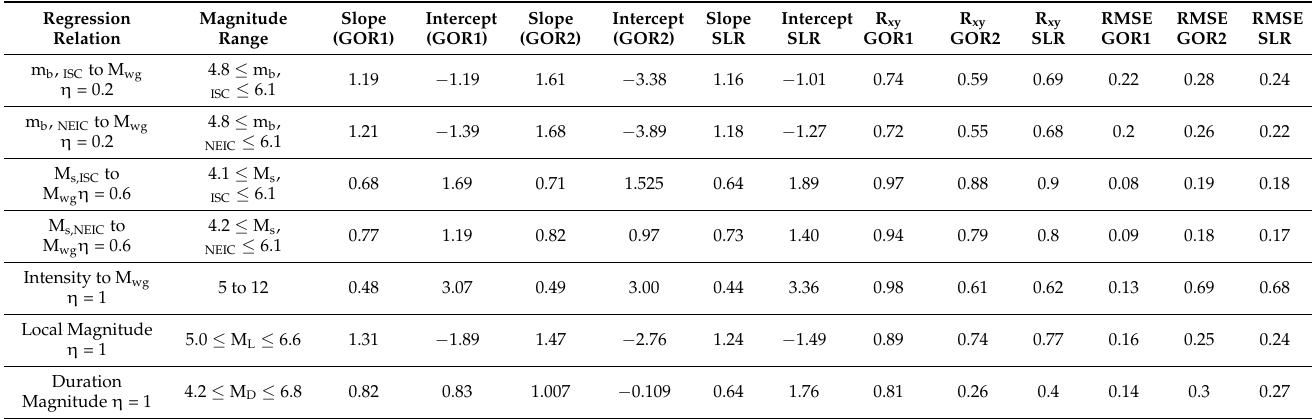
Table 2. Comparisons of regression parameters of GOR1, GOR2 and SLR for Northeast India Region Datasets.